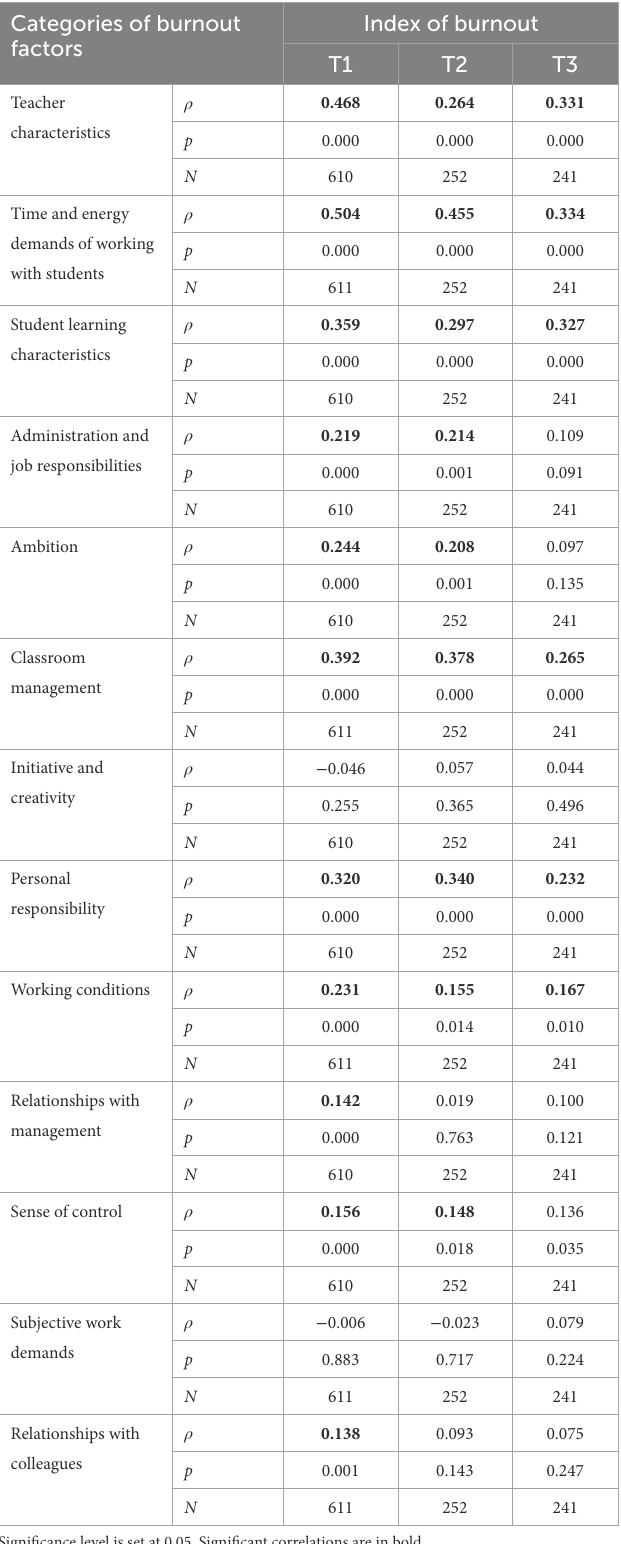
TABLE 10 Bivariate correlation between burnout index and categories of factors of burnout in three time points. Categories of burnout